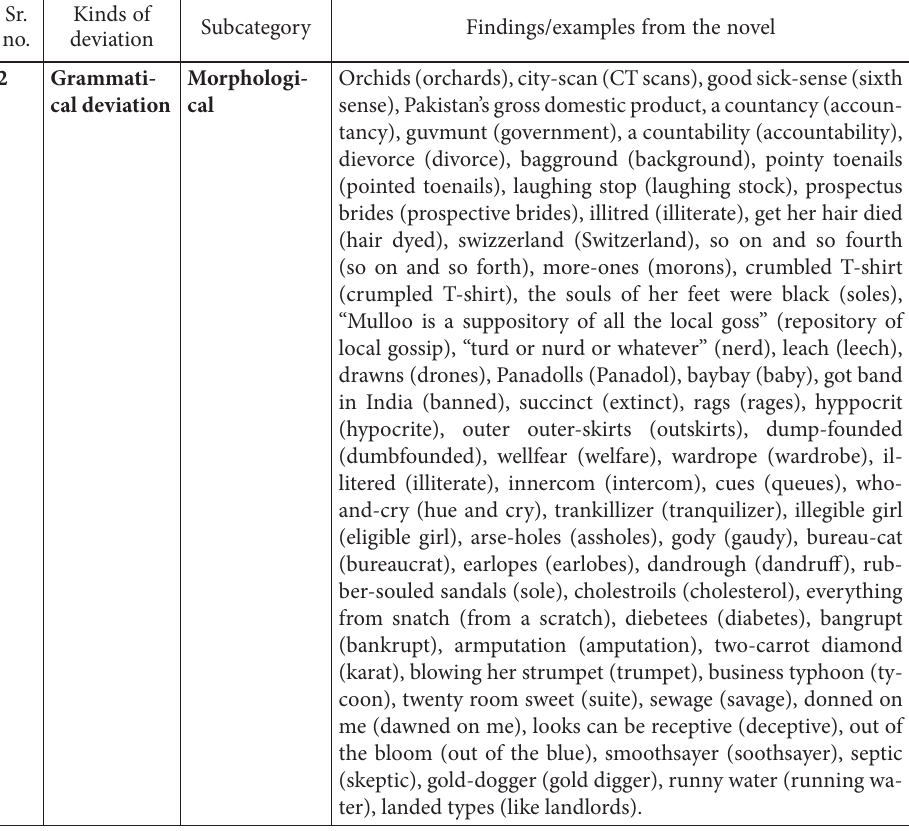
Table 2. Types and examples of grammatical deviation in Moni Mohsin’s Duty Free (a novel) (source: created by author) Sr.